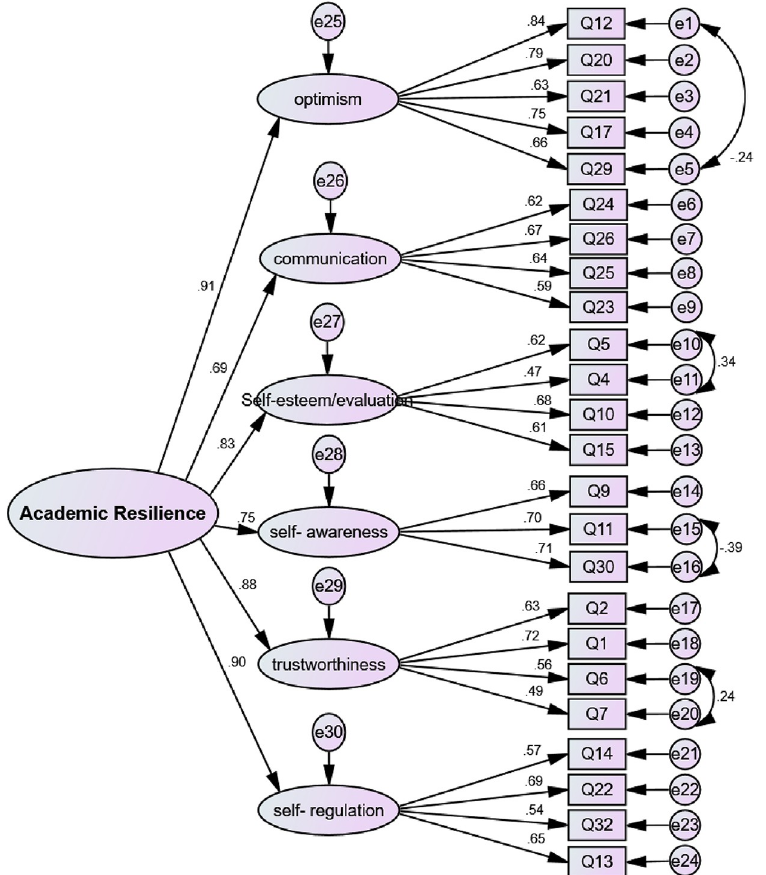
Fig 2. The second-order factor analysis of the NSARI.